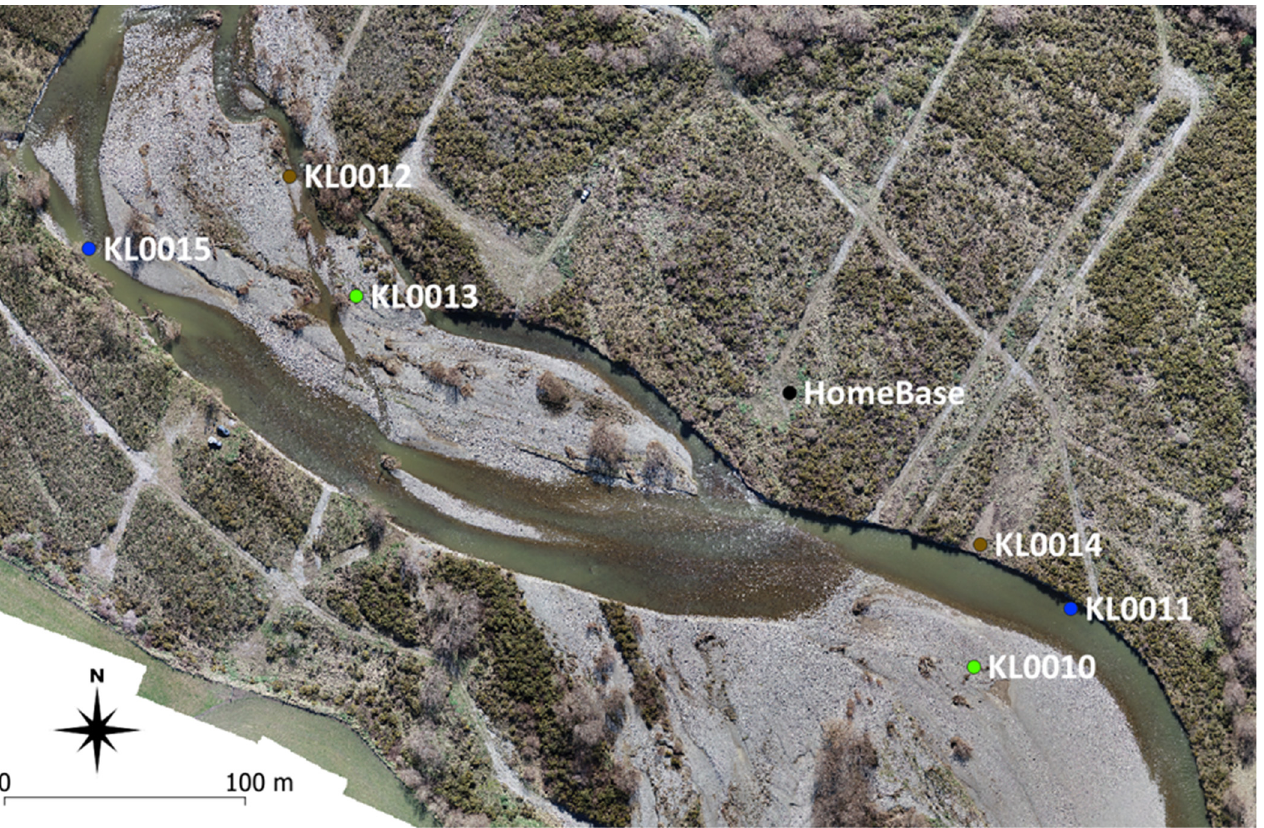
Figure 9. Deployment locations of Kinematic Logger units during field recovery tests. Green dots are units located on the surface, brown dots are buried units, and blue dots are underwater units. Table 2. Kinematic Loggers deployed during field recovery tests.